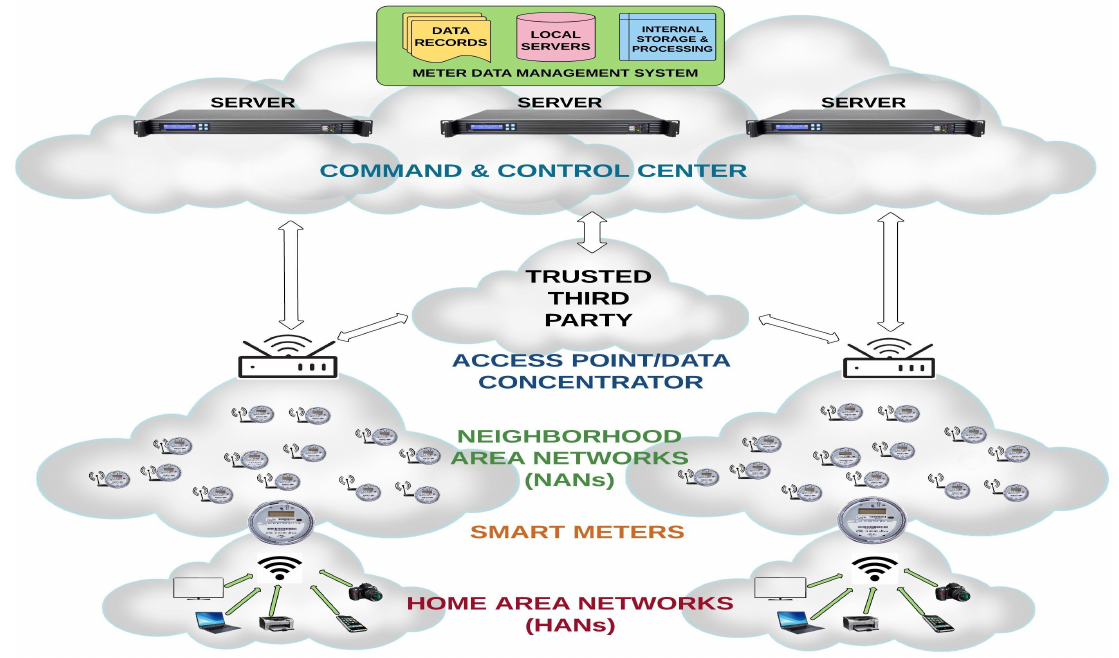
Figure 1. The proposed advanced metering infrastructure (AMI) architecture consists of the home area network (HAN), the neighborhood area network (NAN), the trusted third party (TTP), the data concentrator and the control